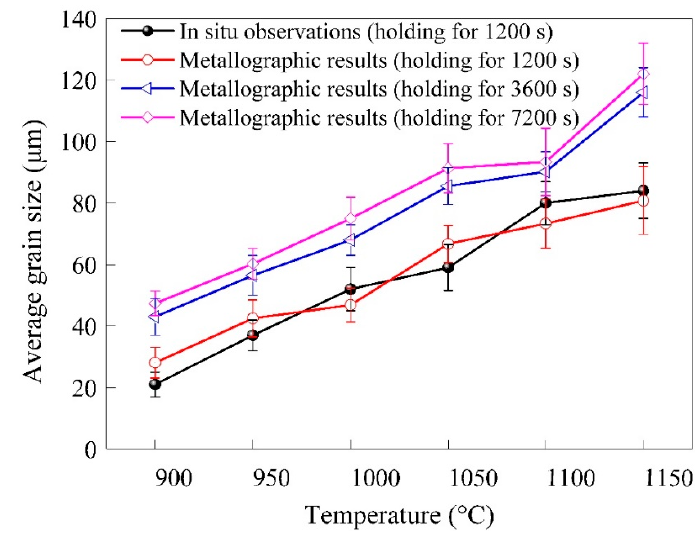
Figure 9. Comparison of the metallographic results and the in situ results.